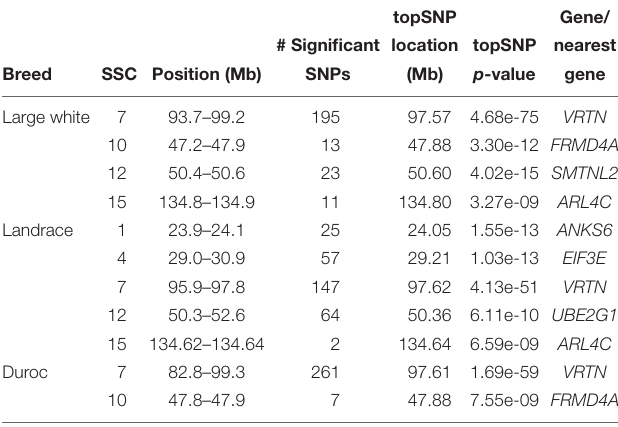
TABLE 3 | Genomic regions associated with NTE in LW, L, and D populations.